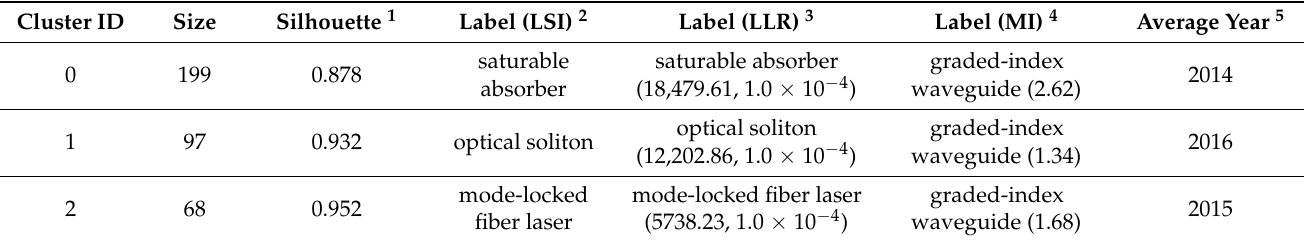
Table 1. Summary of the largest 3